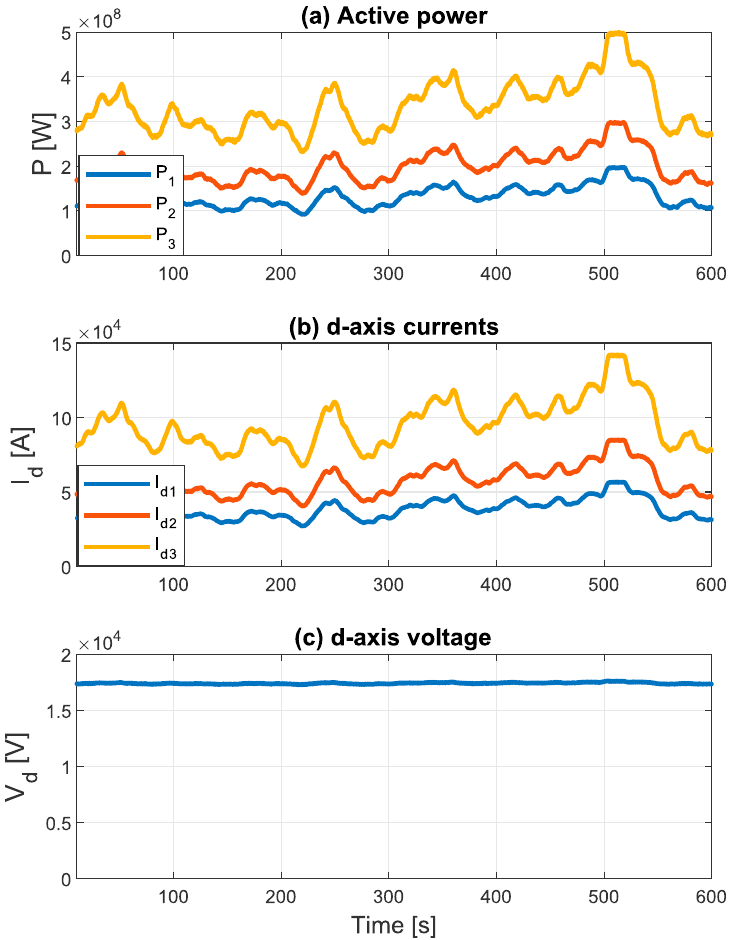
Figure 17. ( a ) Active power and ( b ) d-axis currents supplied by the individual inverters; ( c ) d-axis voltage (PCC voltage).